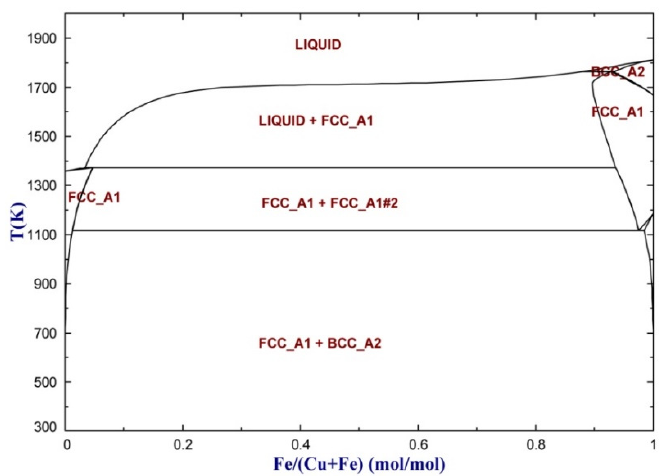
Figure 4. Cu-Fe phase diagram from FactSage 7.3 databases [32].